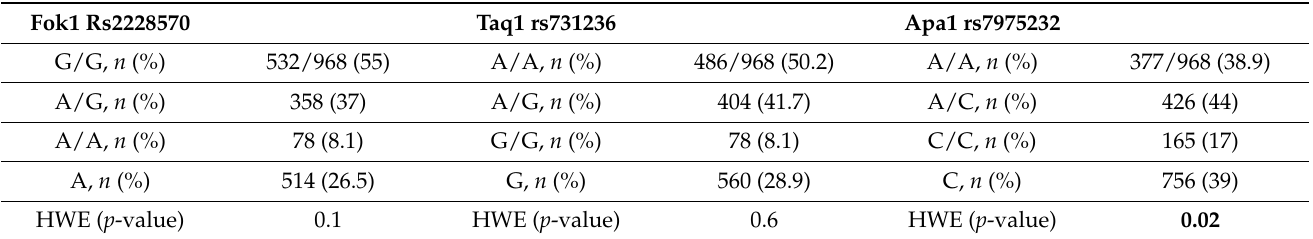
Figure 2. Using the Global Consensus Recommendations on Prevention and Management of Nu- tritional Rickets vitamin D deficiency, vitamin D-binding protein ( µ g/mL) levels were found to be significantly decreased in the deficient vitamin D group, mean ± SD, 300 ± 57 ( µ g/mL) ( N = 54), compared to the insufficient vitamin D group, 312 ± 77 ( N = 379), and the sufficient vitamin D group, 327 ± 83 ( N = 126), ( p = 0.003). BP, binding protein. Table 4. Genotype distributions and minor allele frequencies (HWE: Hardy–Weinberg